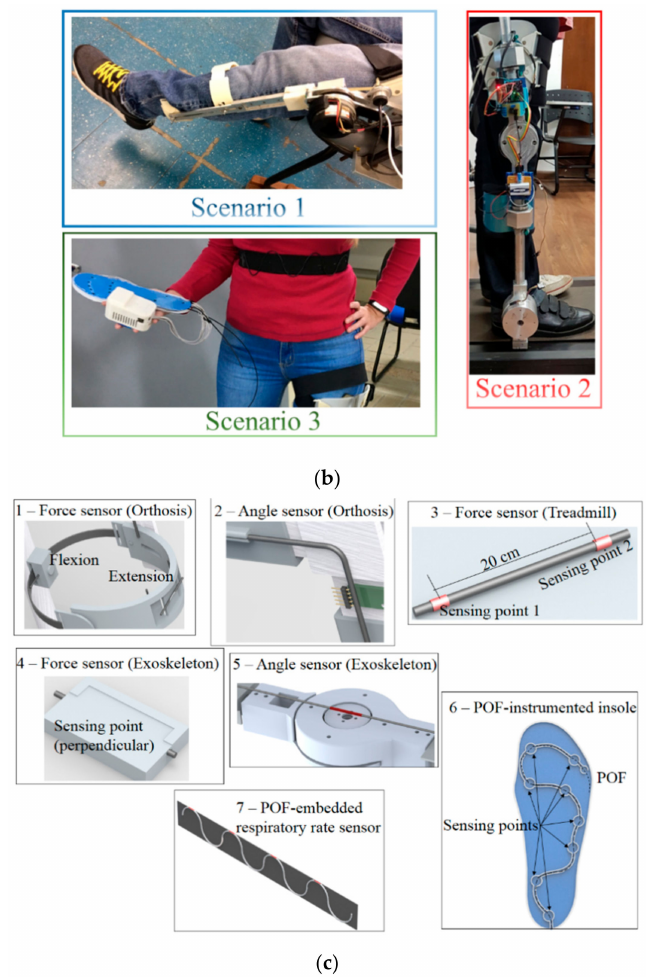
Figure 1. ( a ) Schematic representation of the scenarios proposed, ( b ) a photograph of the devices for each scenario and ( c ) the devices used for the polymer optical fiber (POF)-instrumented robot-assisted rehabilitation